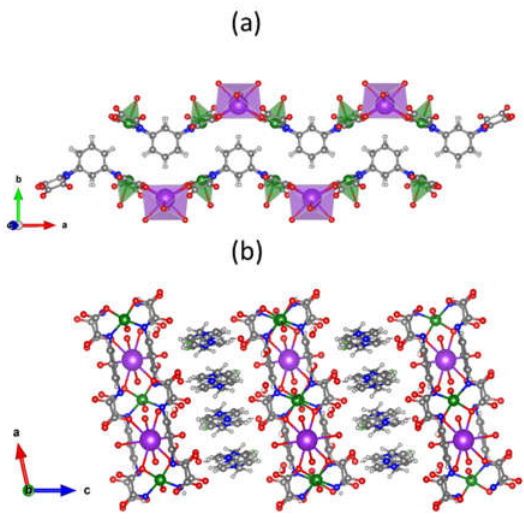
Figure 4. ( a ) View of the packing of two adjacent heterobimetallic chains along the crystallographic a axis in 2 . EDAP 2+ cations are omitted for clarity. ( b ) Intercalated layers of EDAP 2+ cations separating the layers of {K(H 2 O) 4 [Cu 2 ( µ -mpba) 2 (H 2 O) 2 ]} n3n − polymers packed along the crystallographic ab plane. The crystallization water molecules were omitted in both figures for the sake of clarity.